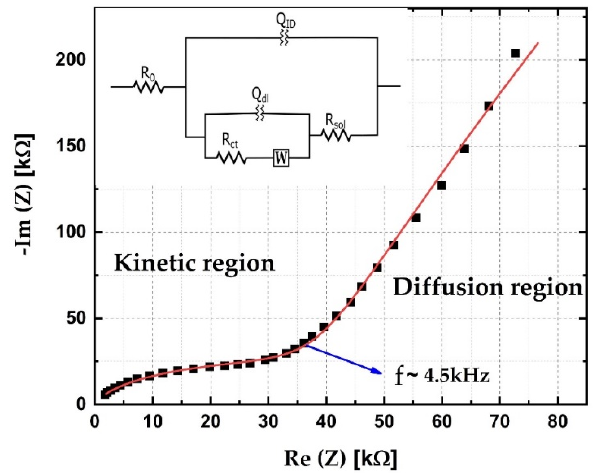
Figure 11. Nyquist plot of experimental (symbols) and fitted results (line) with equivalent circuit (inset). Table 2. Values for imaginary and real parameters of equivalent circuit.